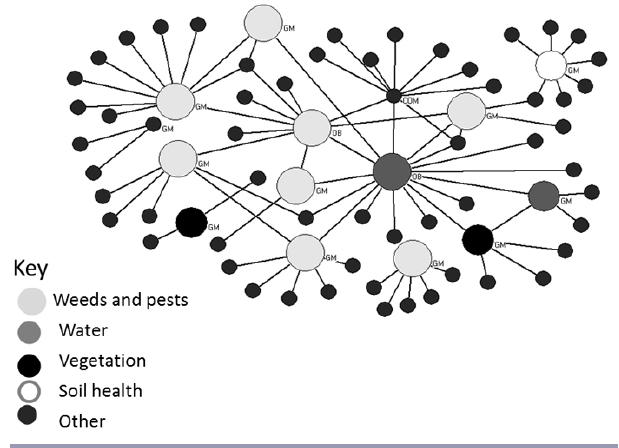
Fig. 1 . High priority natural resource management issues for Landcare Group A